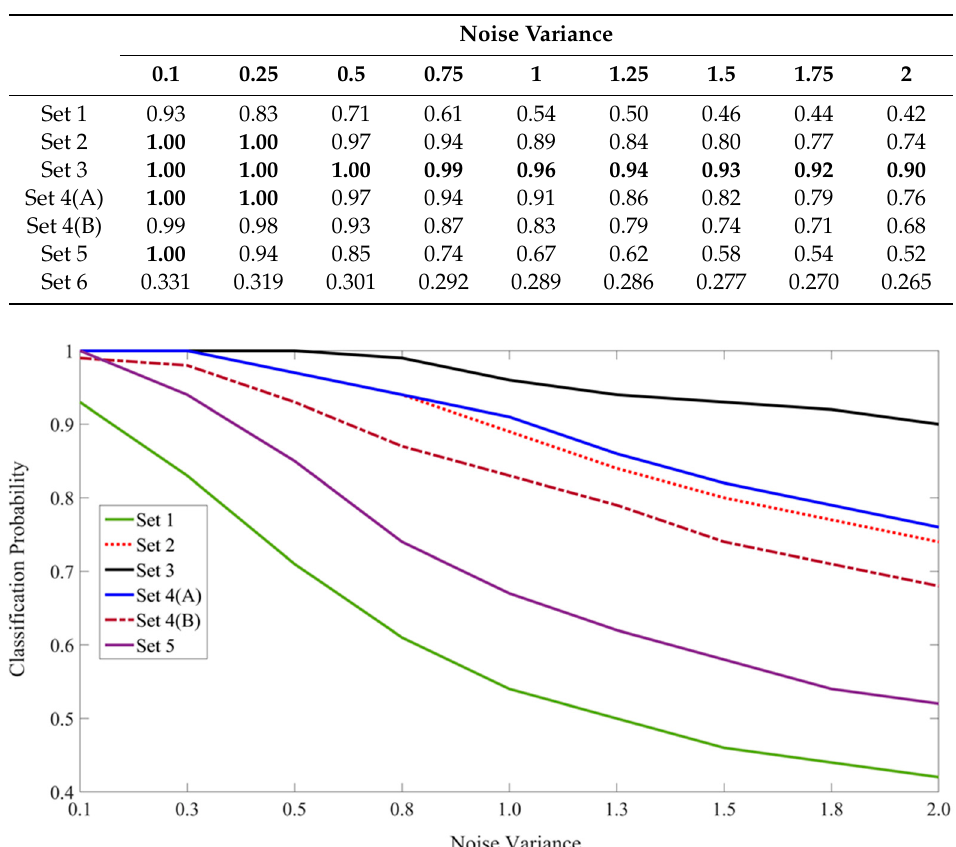
Table 2. Classification probabilities for the six sets of experiments involving target letters.